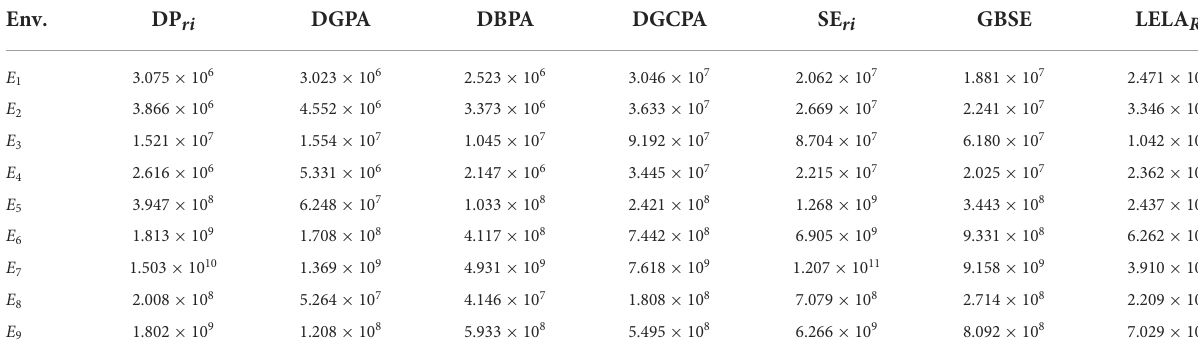
TABLE 4 The parameter tuning cost (number of extra interactions) of the compared algorithms in environments E 1 – E 9 . Env.